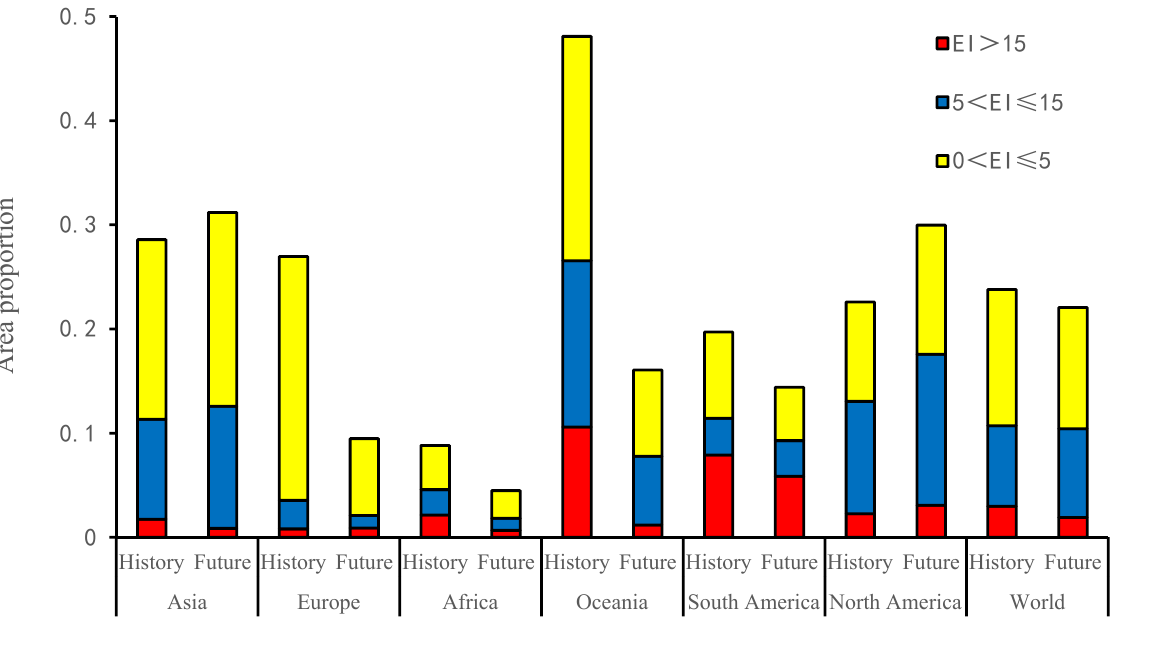
Figure 7. Percentage of the suitable area of Apocheima cinerarius in different continents under historical and future conditions.